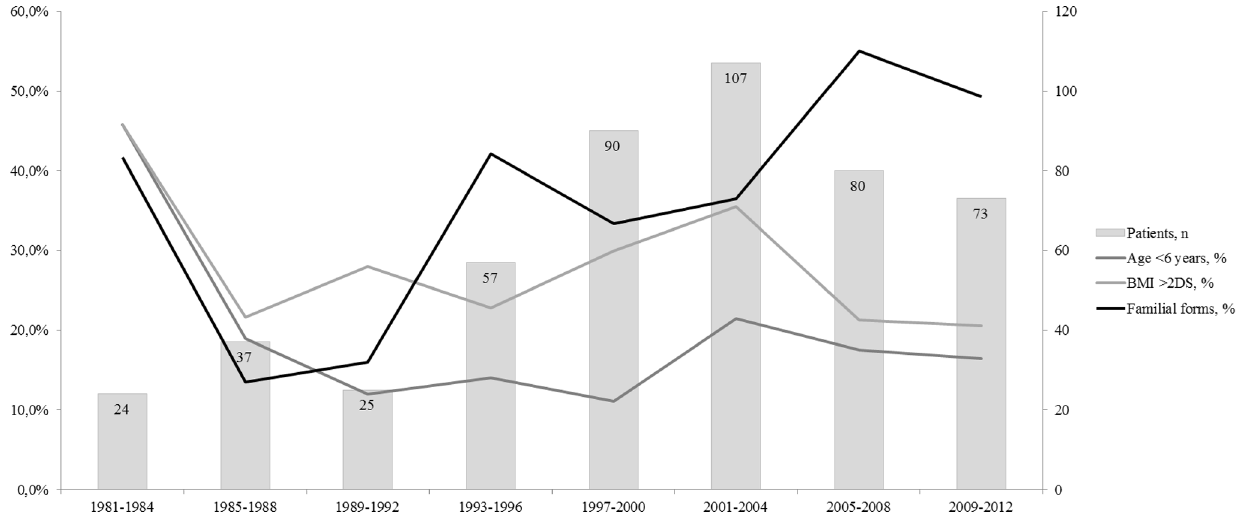
Figure 2. Evolution of the numbers and characteristics over 31 years of 493 girls with idiopathic CPP.